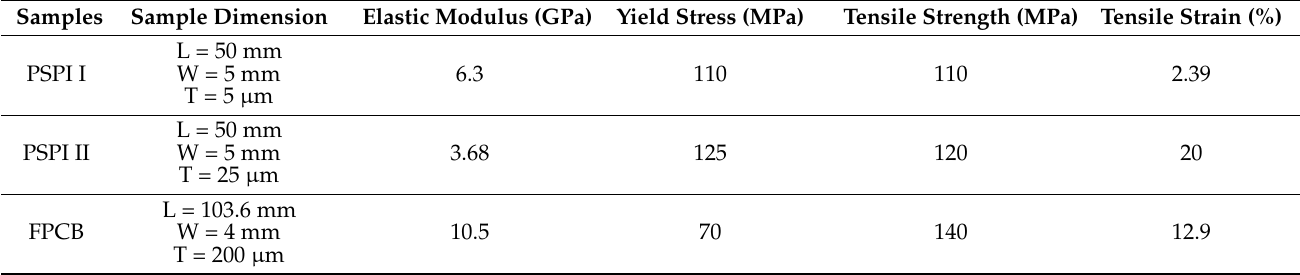
Table 1. Summary of FPCB and PSPI mechanical properties.